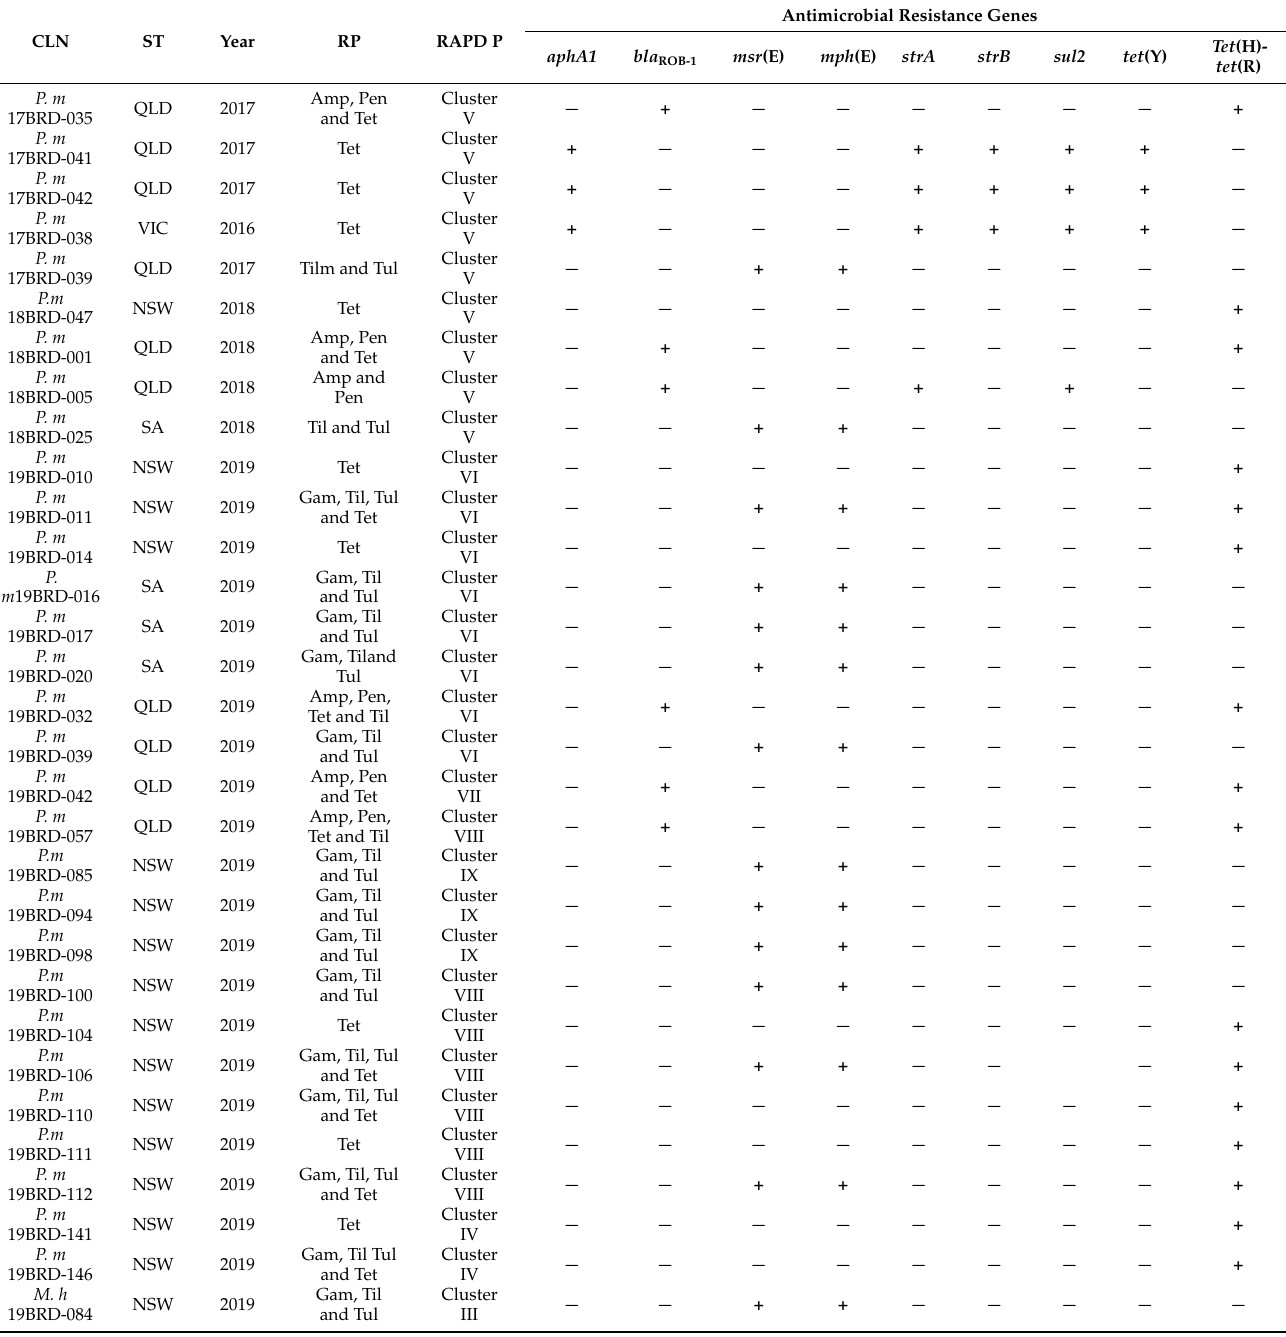
predominately of QLD isolates (5/15 and 17/28, respectively). Clusters VII and X contained isolates exclusively from QLD (two and five isolates, respectively) (Figure S2, Table 8). WGS was undertaken on all isolates per cluster, including isolates exhibiting resistance to one or more antimicrobials or obtained from distinct feedlots in different Australian states of origin. Table 8. Resistance profile, RAPD pattern and presence of antimicrobial resistance genes among isolates of Pasteurella multocida (P. m) ( n = 28) and Mannheimia haemolytica (M. h) ( n = 1) +, present, − , absent. Antimicrobial Resistance Genes CLN ST Year RP RAPD P aphA1 bla ROB-1 msr (E) mph (E) strA strB sul2 tet (Y) Tet (H)- tet (R) QLD Amp, Pen and Tet Cluster V Tet Cluster V +